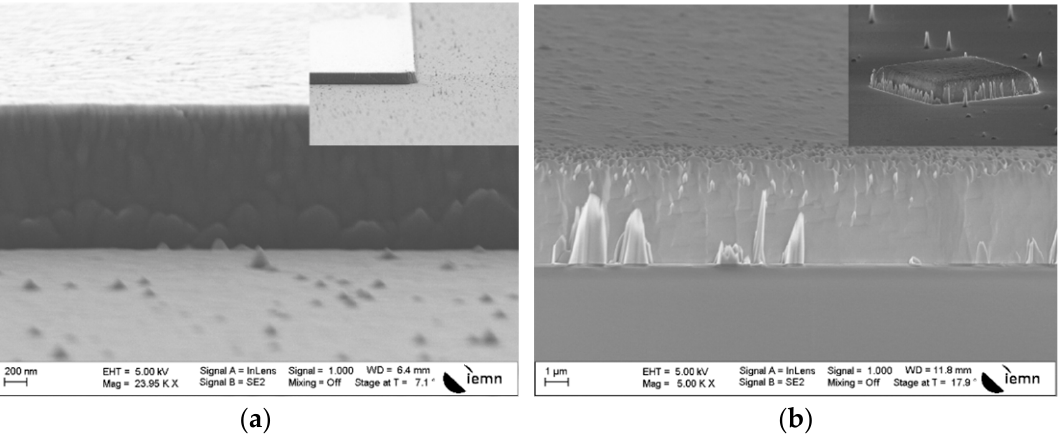
Figure 3. ( a ) Cross section SEM images of InGaN/GaN MQW structure after ICP etching with etching depth of 1 µm with SiO 2 mask, and ( b ) observation of mesa sidewall etching with SiO 2 mask (Etching depth of 4 µm at 500 Watts ICP power).